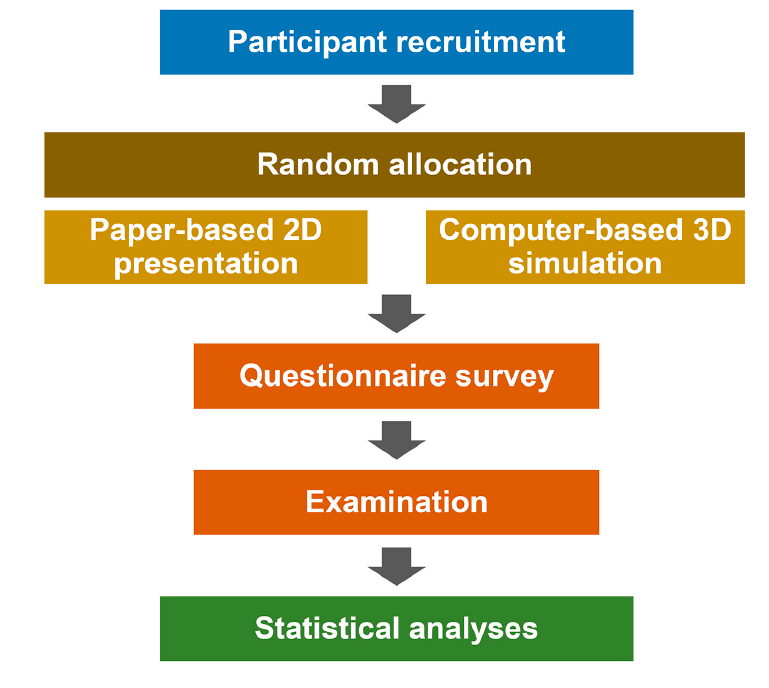
Figure 1. Workflow for this study.